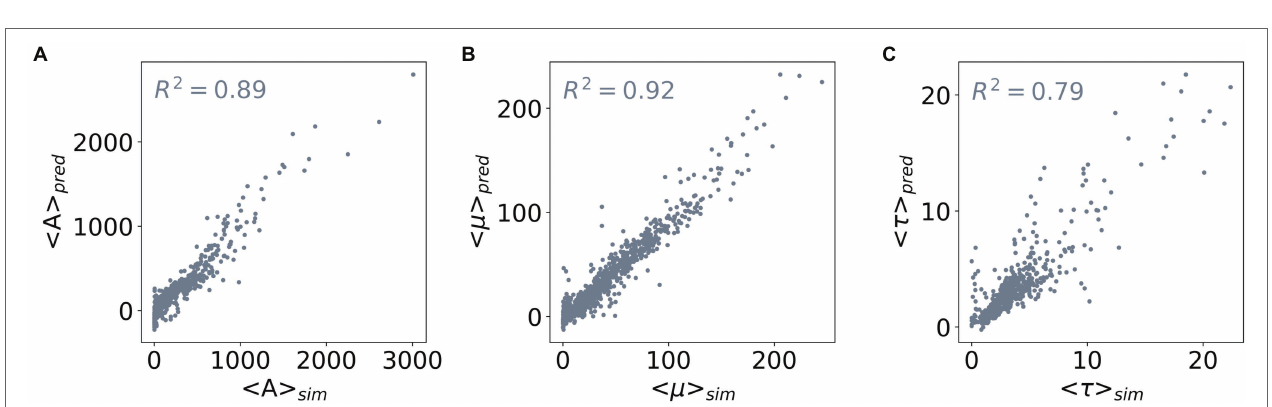
FIGURE 4 | Correlation between the predicted and simulated values of the three outputs. The three outputs are (A) <A>, (B) < μ >, and (C) < τ >. The x -axis shows the average values of an output derived from the population curves (<> sim ), and the y -axis shows the average values predicted by a feed-forward neural network (<> pred ). The R 2 scores of the network model used for the three output predictions are included in the